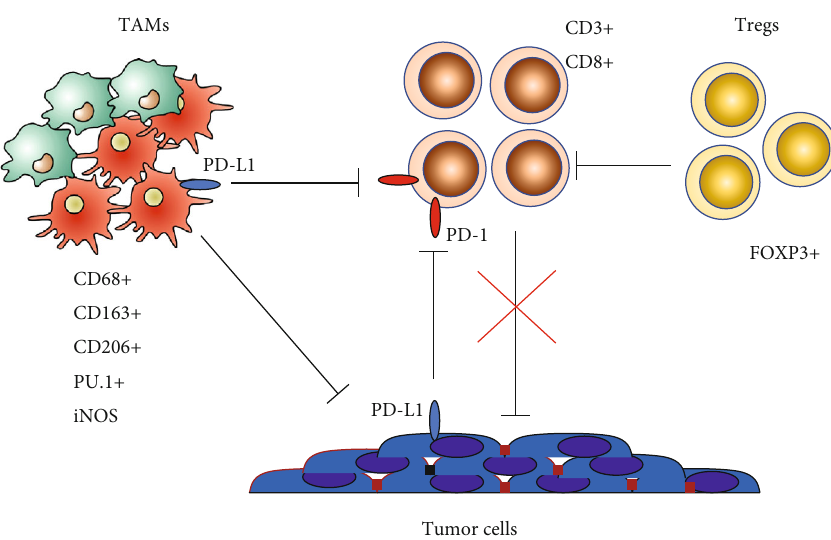
Figure 4: Immunosuppressive cells of esophageal squamous cell carcinoma